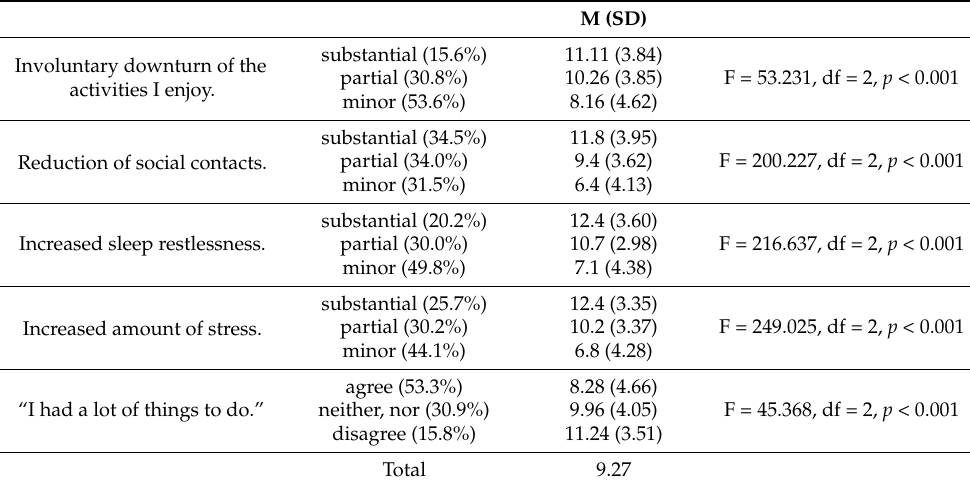
Table 4. PDLD scores by experienced